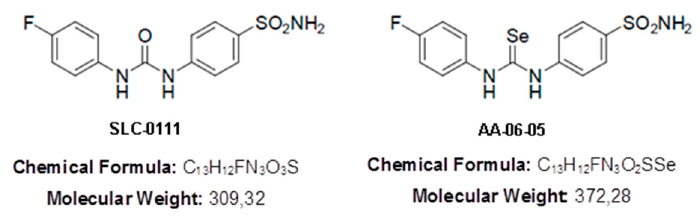
Figure 9. SLC-0111 and AA-06-05 chemical structures.